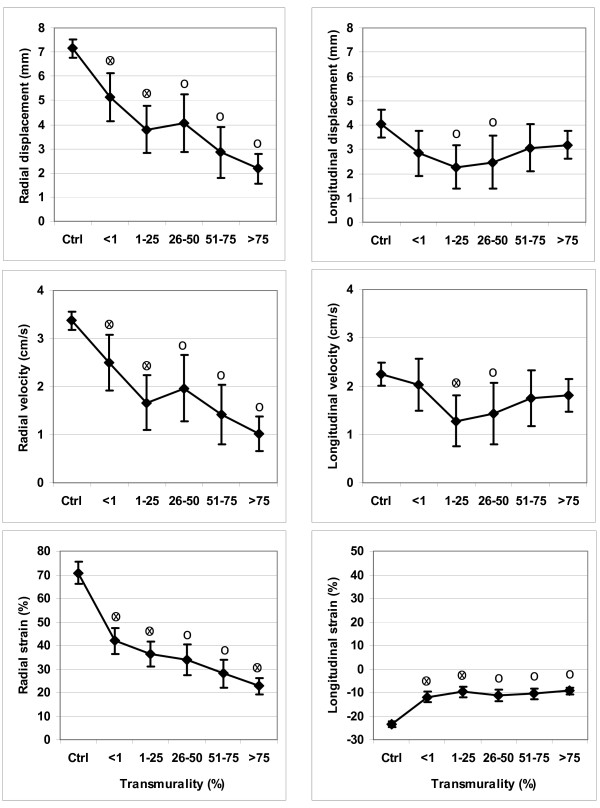
Functional measures vs. transmurality, all patients (Ctrl = non-scar). Left-sided panels show radial displacement (upper), velocity (mid) and strain (lower) in segments with various degree of transmurality. Right-sided panels show the corresponding longitudinal values. o = denotes statistically significant difference (p < 0.05) compared to controls (Ctrl) x = denotes statistically significant difference (p < 0.05) compared to nearest left value